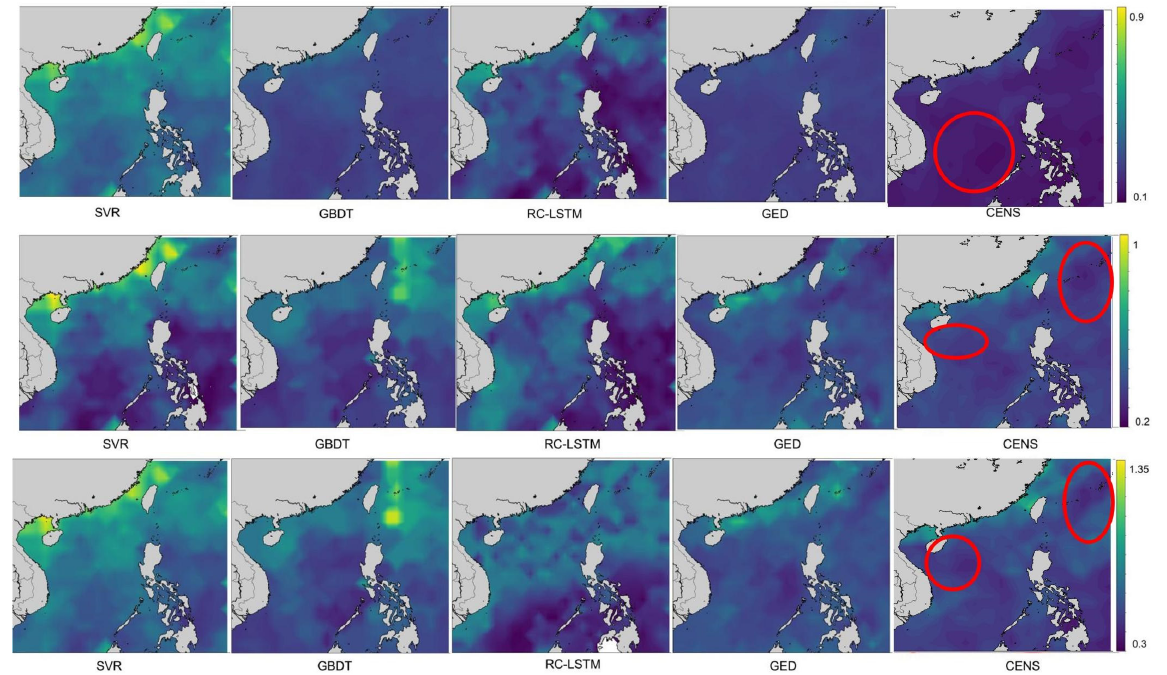
Figure 7. Error distribution in the South China Sea for different models in 1, 3, and 7-day sea surface temperature prediction. The error plots of SVR, GBDT, RC-LSTM, GED, and CENS are shown from left to right, and the error results of prediction one day, prediction three days, and prediction seven days are shown from top to bottom. The color bar on the right is the MAE value.